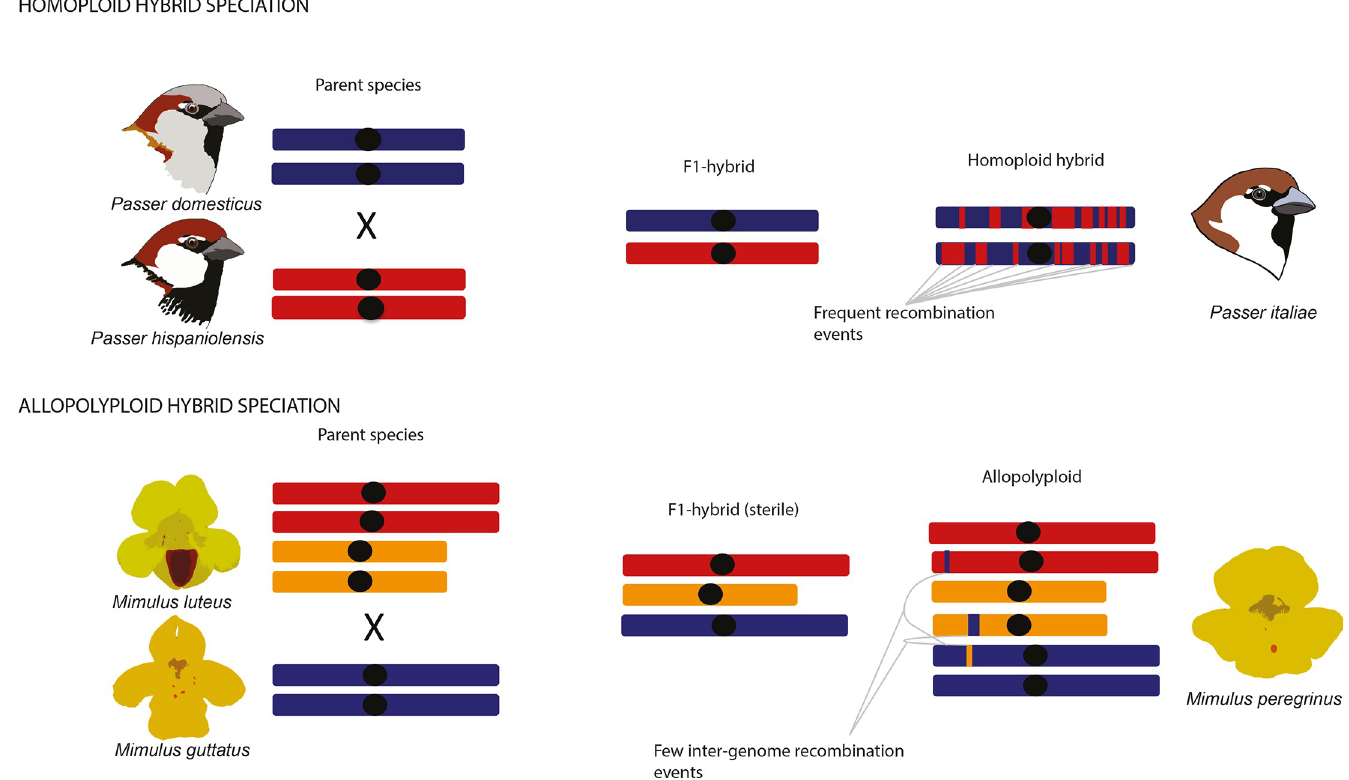
Fig 2. Schematic representation of homoploid and allopolyploid hybrid speciation. As an example of a homoploid hybrid genome we present a schematic figure of the mosaic genome of the Italian sparrow which is a hybrid resulting from the anthropogenic house sparrow P. domesticus which spread across the Mediterranean with agriculture and encountered and hybridized with local populations of Spanish sparrow P. hispaniolensis [44,47,85].As allopolyploid example we use the monkeyflower Mimulus peregrinus , an allohexaploid species that has evolved independently at least twice and which involves an intermediate, sexually-sterile but clonally vigorous F1 hybrid [115]. Sterile F1 hybrids have given rise to allopolyploids in other taxa (e.g. Spartina and Senecio ), but allopolyploids can also form via fertile intermediate hybrids (e.g. Tragopogon